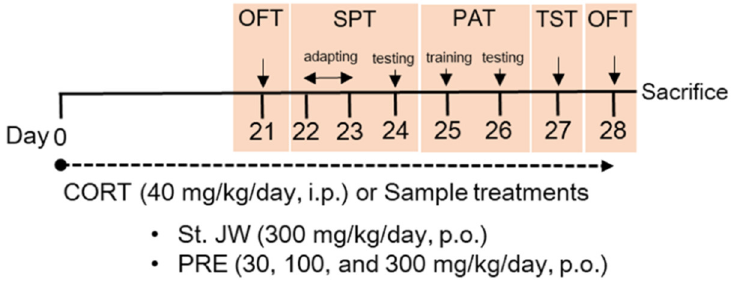
Figure 7. Experimental design for animal model of CORT-induced depression-like behavior. CORT, corticosterone; OFT, open-field test; SPT, sucrose preference test; PAT, passive avoidance test; TST, tail suspension test; FST, forced swim test; St. JW, St. John’s wort extract; PRE, P. resupinata